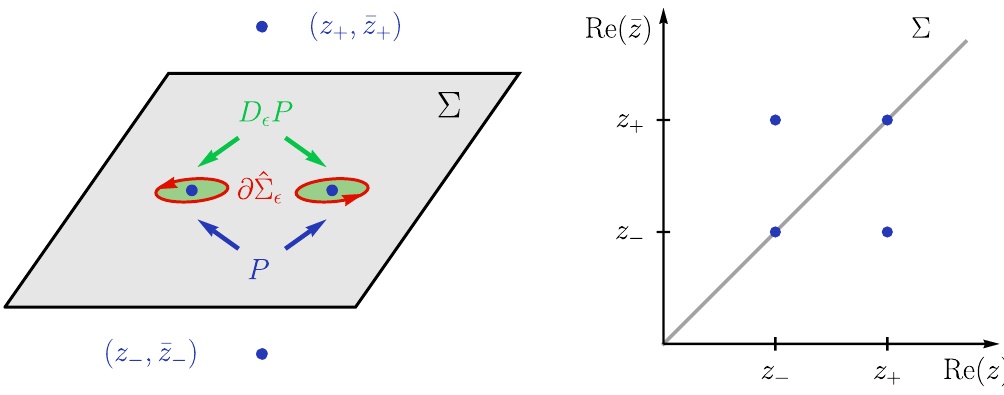
Figure 1 . Sketch of the geometry of the various points and surfaces involved in the localization of the toy integral. In the left (cid:12)gure (cid:6) denotes the integration cycle, the green disks D (cid:15) P denote the excision of the singularities P . The two points ( z (cid:6) ; z (cid:6) ) outside of the integration cycle (cid:6) are the solutions to eq. (2.8). The right (cid:12)gure shows the relative positions of all the points and (cid:6) in the subspace Im( z ) = Im( z ) =